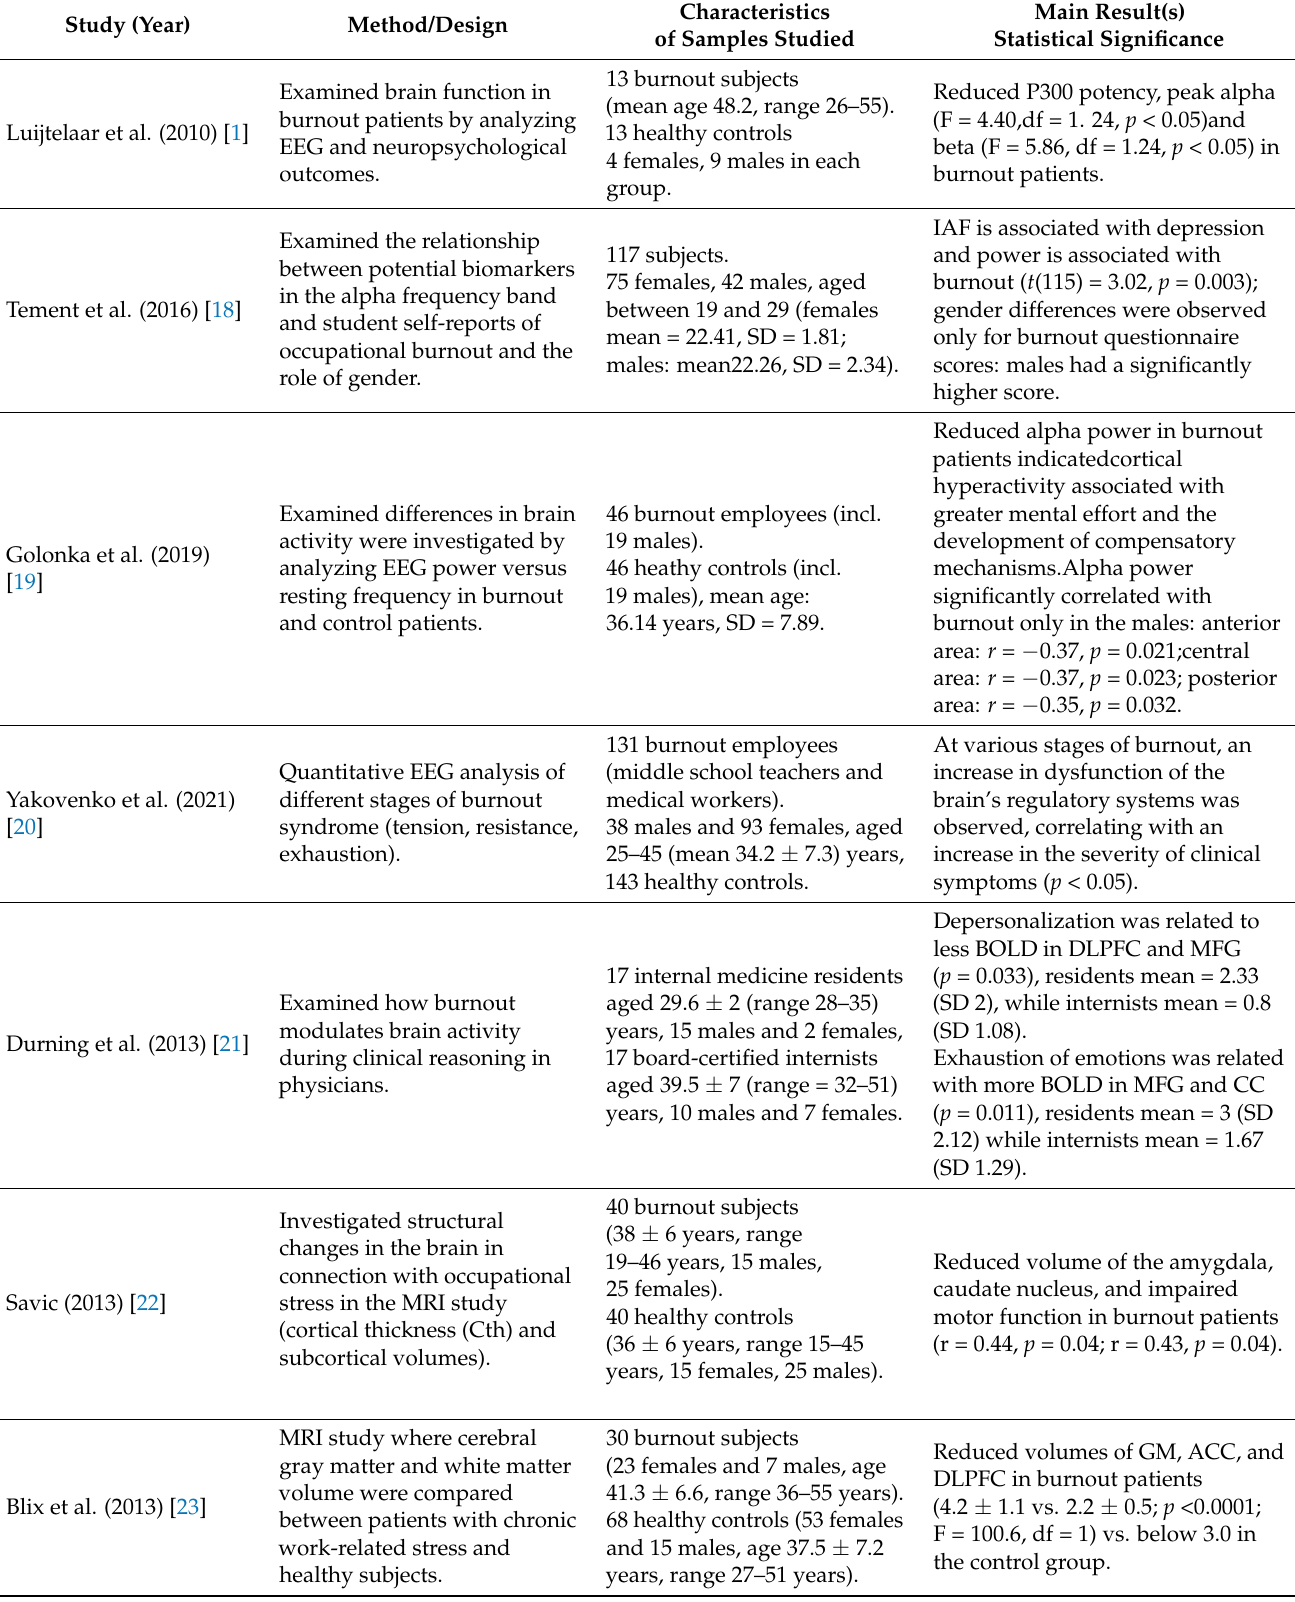
Table 1. Included studies concerning burnout